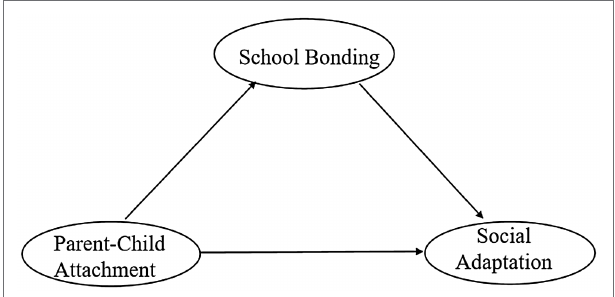
FIGURE 1 | Hypothetical